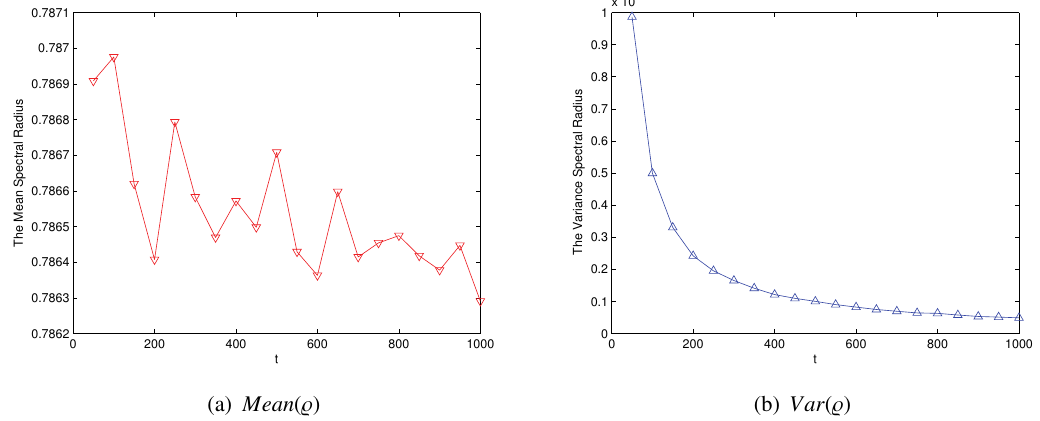
Figure 5: The joint spectral radius and the number of generations from 100 to 1000.